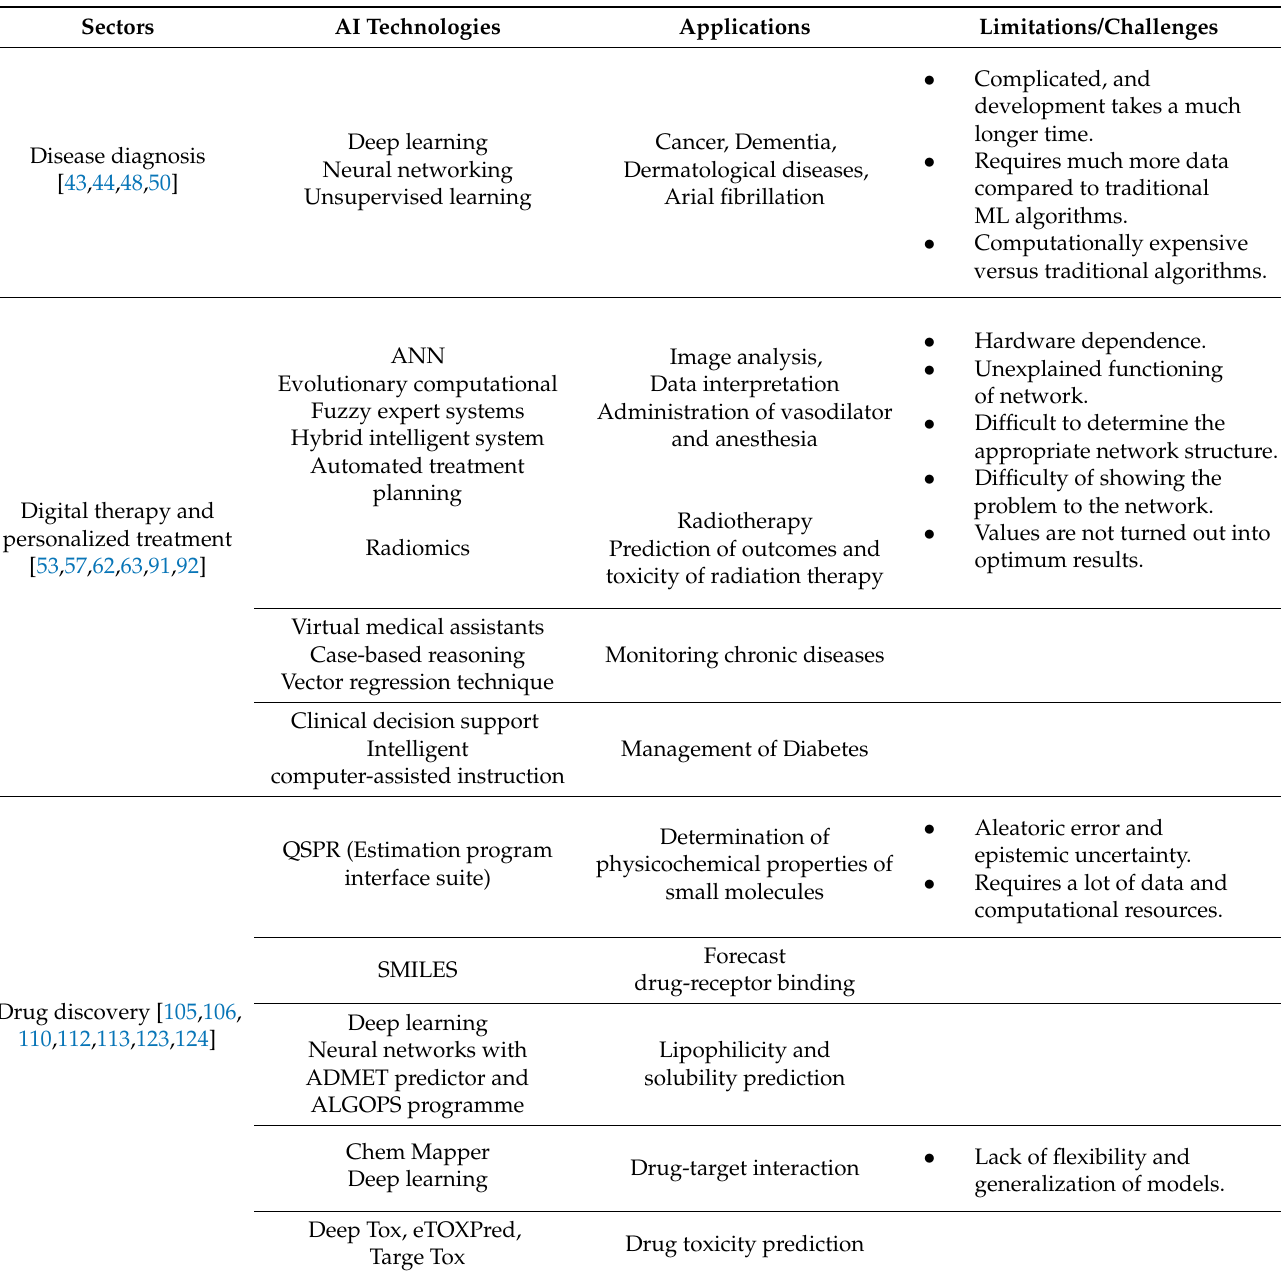
Table 1. A comprehensive detail of AI applications and their limitations/challenges in healthcare and pharmaceutical